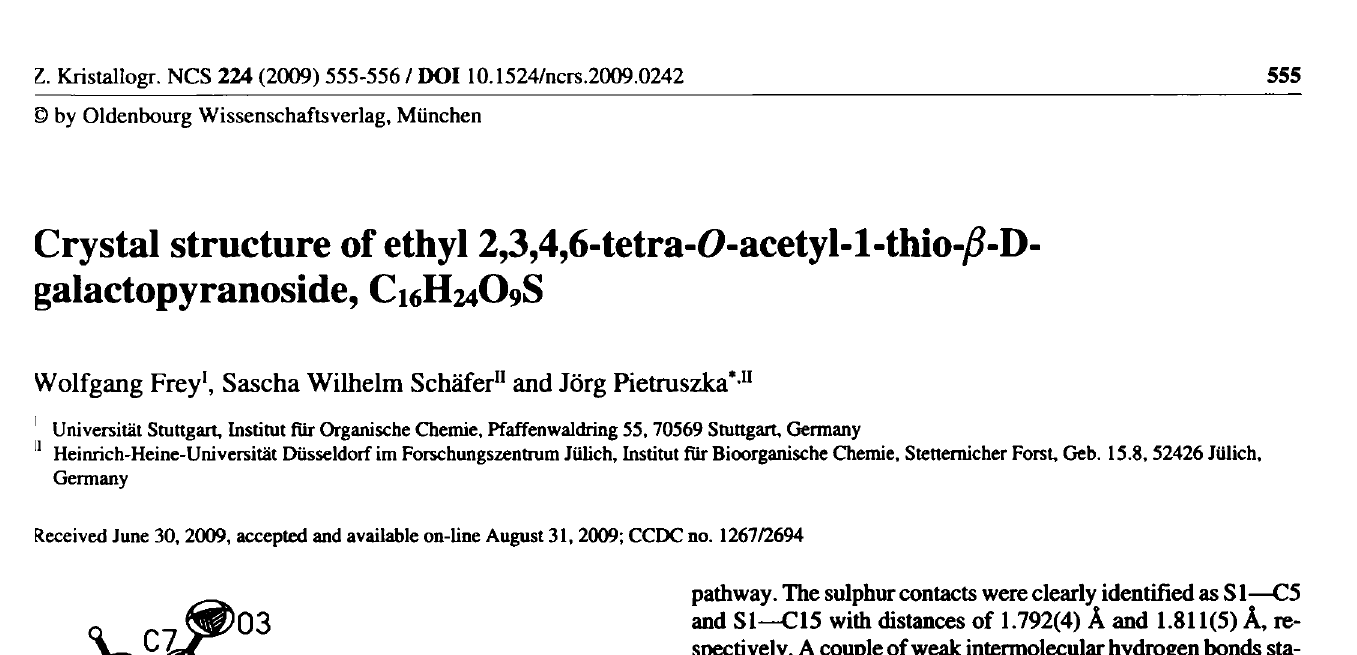
Table 1. Data collection and handling.